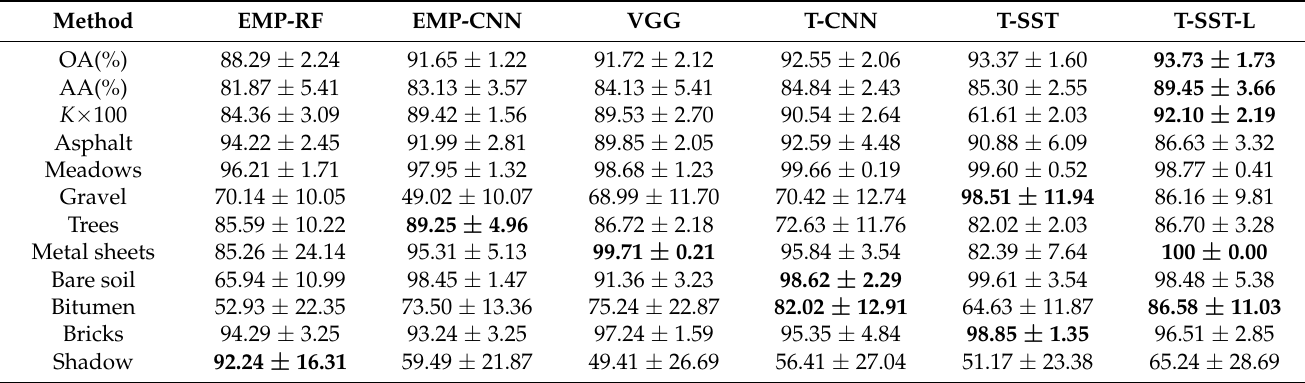
Table 6. Test accuracy with different preprocessing methods on the Pavia